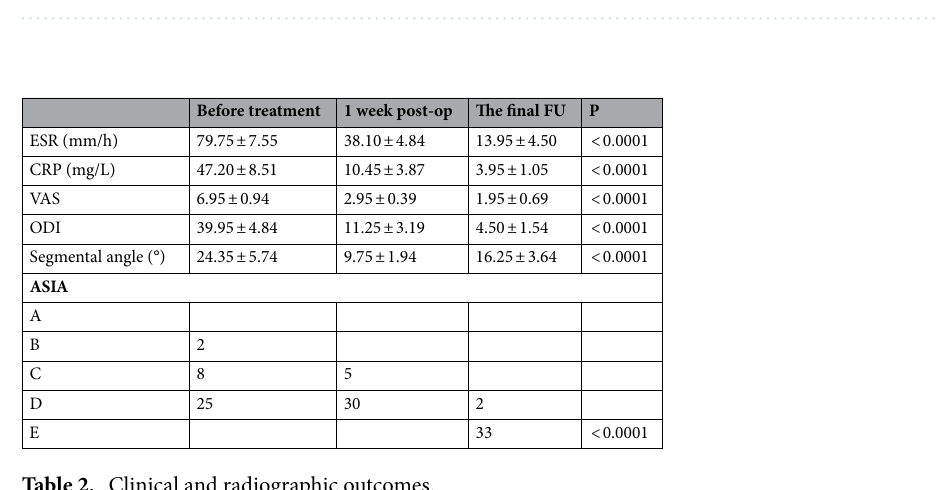
Table 1. Patient characteristics.